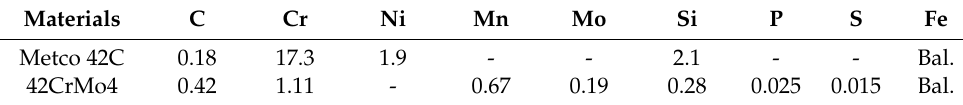
Table 1. Chemical composition of Metco 42C and 42CrMo4 steel (wt. %). Materials C